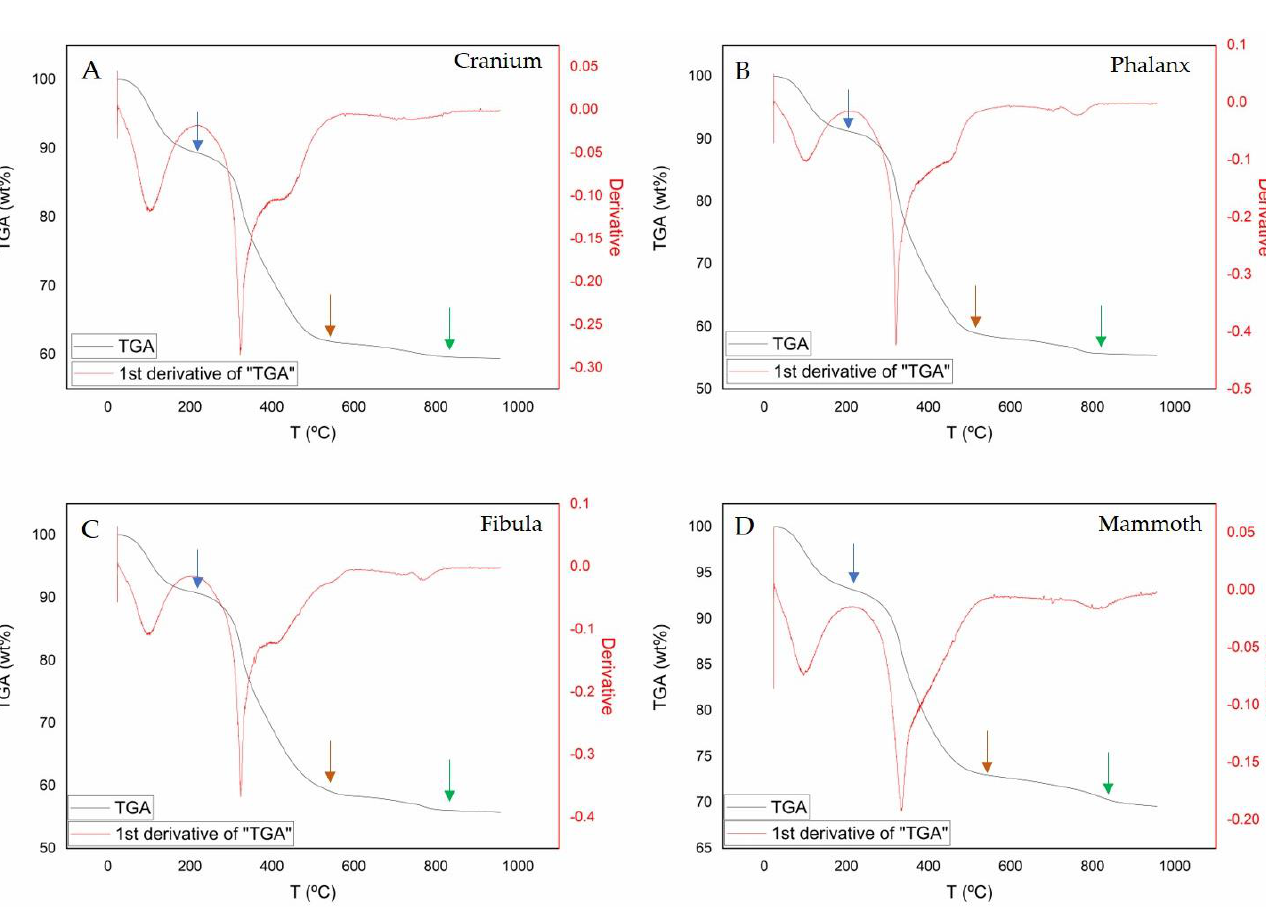
Figure 3. Thermogravimetric traces (black) and first derivate (red) of the bones studied showing three different weigh losses up to 200 °C corresponding to water loss (blue arrows), up to 580 °C corresponding to organic matter (orange arrows), and weigh loss up to 850 °C corresponding to carbonates (green arrows). ( A ). Cranium bone sample. ( B ). Phalanx bone sample. ( C ). Fibula bone sample. ( D ). Mammoth bone sample. Table 3. Thermogravimetric analyses indicating the relative weight loss of water, organic matrix (OM), carbonates, and phosphates in bone samples (see further details in Figure 3).